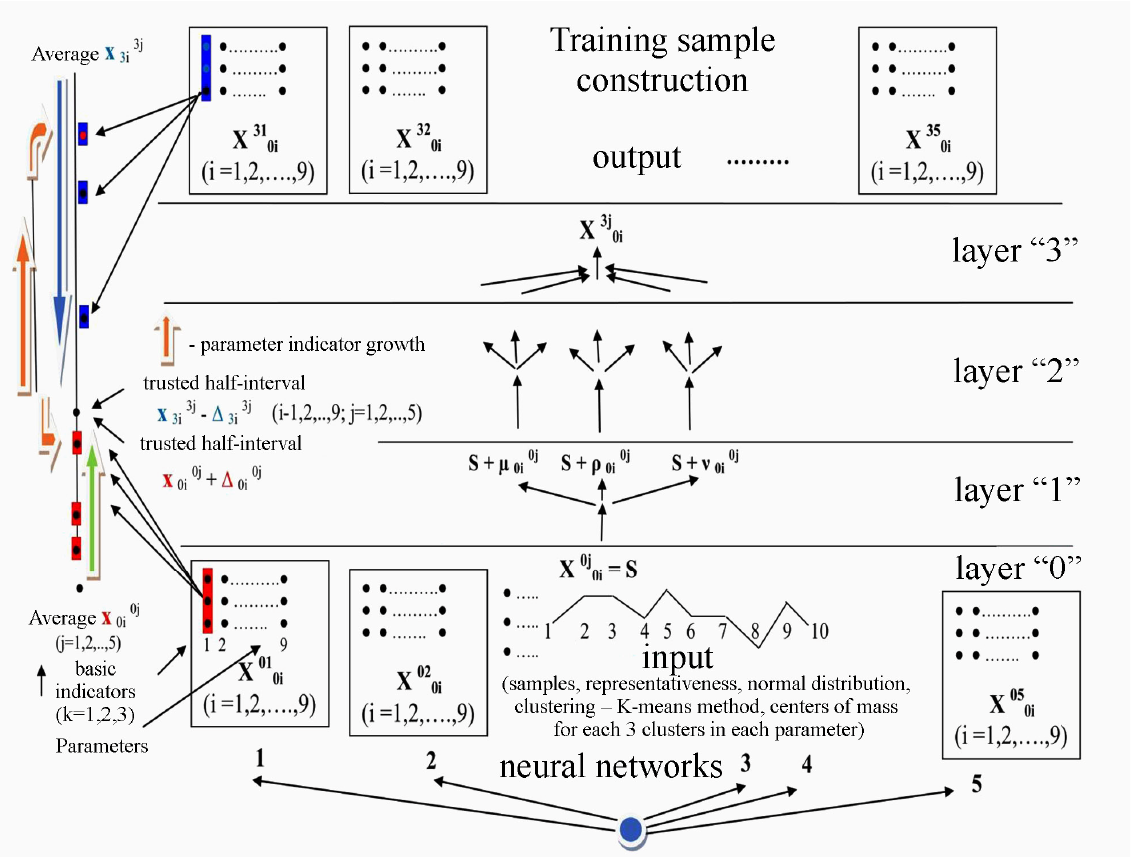
Figure 3. Training sample scenario.